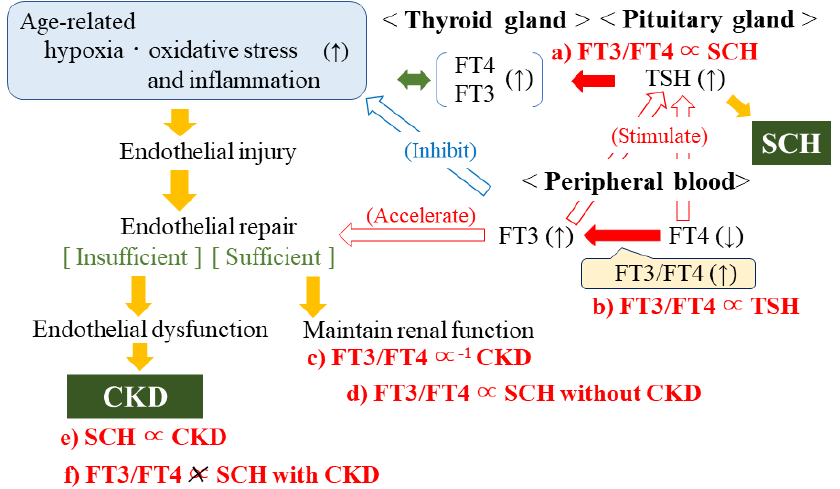
Figure 2. Potential mechanism underlying thyroid hormone and chronic kidney disease. Associations in red ( a – f ) were shown in present study. CKD: chronic kidney disease. FT3: free triiodothyronine. FT4: free thyroxine. TSH: thyroid stimulating hormone. SCH: subclinical hypothyroidism. Age- related physical changes such as increased oxidative stress, hypoxia, or inflammation injure the endothelium. Upon endothelial injury, endothelial repair is activated; insufficient endothelial repair results in progression of CKD. In peripheral blood, FT3/FT4 could act as a maker of endothelial repair activity by indicating thyroid hormone activity. In conjunction with the pituitary gland, the thyroid gland regulates the production of thyroid